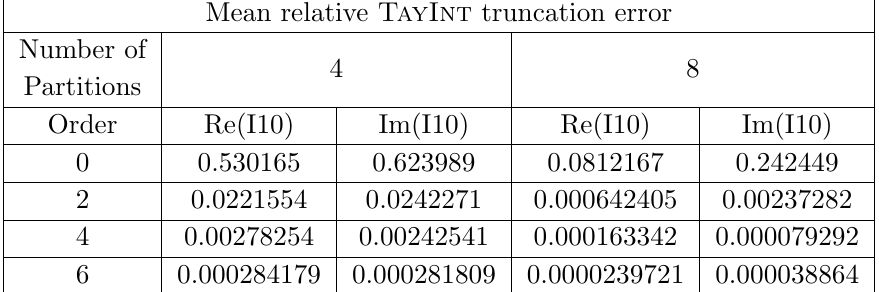
Table 3 . The impact on the mean relative TayInt truncation error of changing the order of the Taylor expansion and the number of partitions in the TayInt algorithm applied to I10 at O ( (cid:15) 0 ). The kinematic region over which the mean is taken is given by u 2 [16 m 2